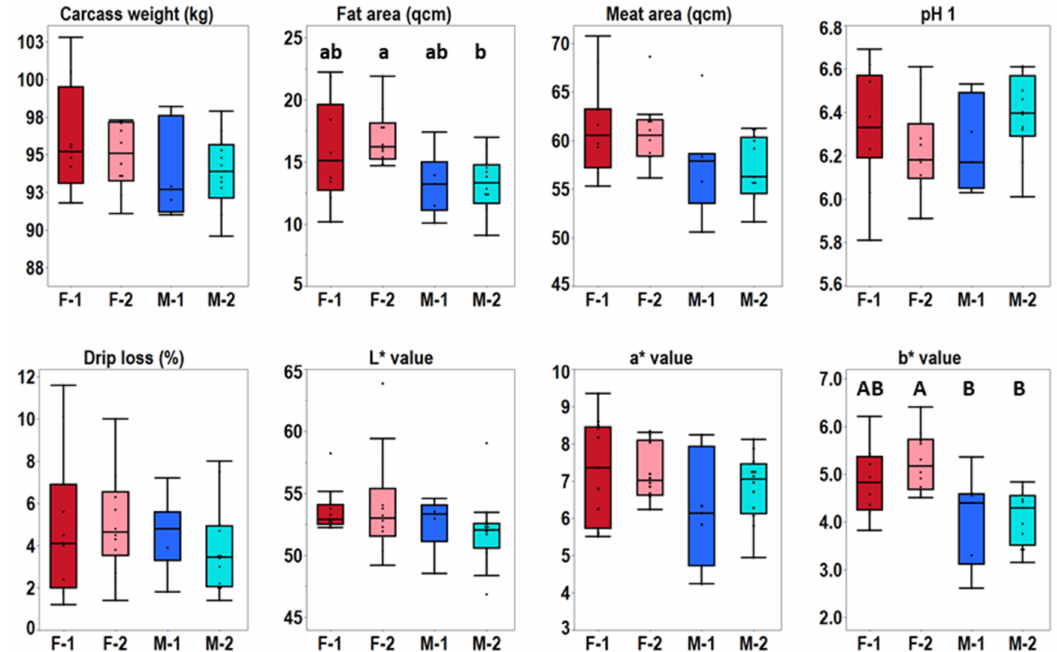
Figure 1. Meat quality data. Statistical differences were calculated using Tukey’s HSD Test. Significant differences are indicated with capital letters: p < 0.01 and lower-case letters: p < 0.05. Abbreviations: F-1 = female PIx(LWxGL), F-2 = female PIxGL, M-1 = male PIx(LWxGL), M-2 = male